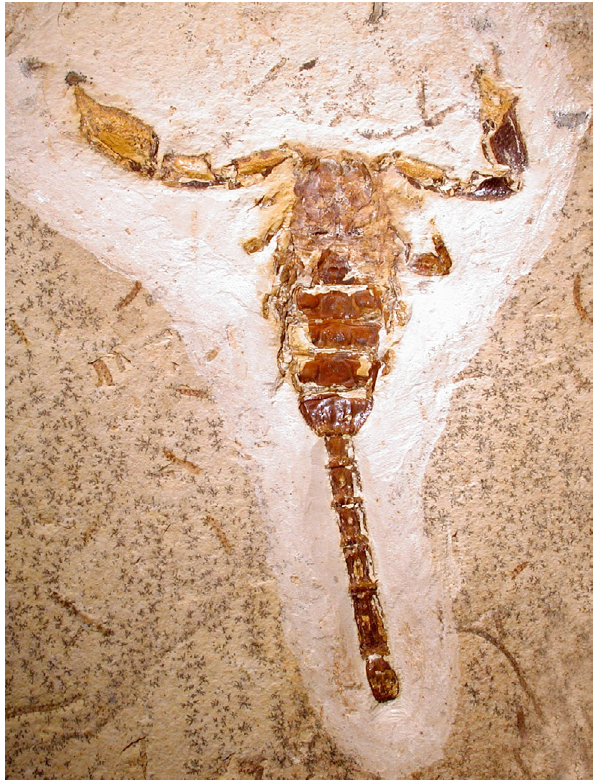
Figure 1. Protoischnurus axelrodorum Carvalho & Lourenço, early Cretaceous fossil from Araripe Basin in Brazil. Telson is bulbous without a sub-aculear tubercle.